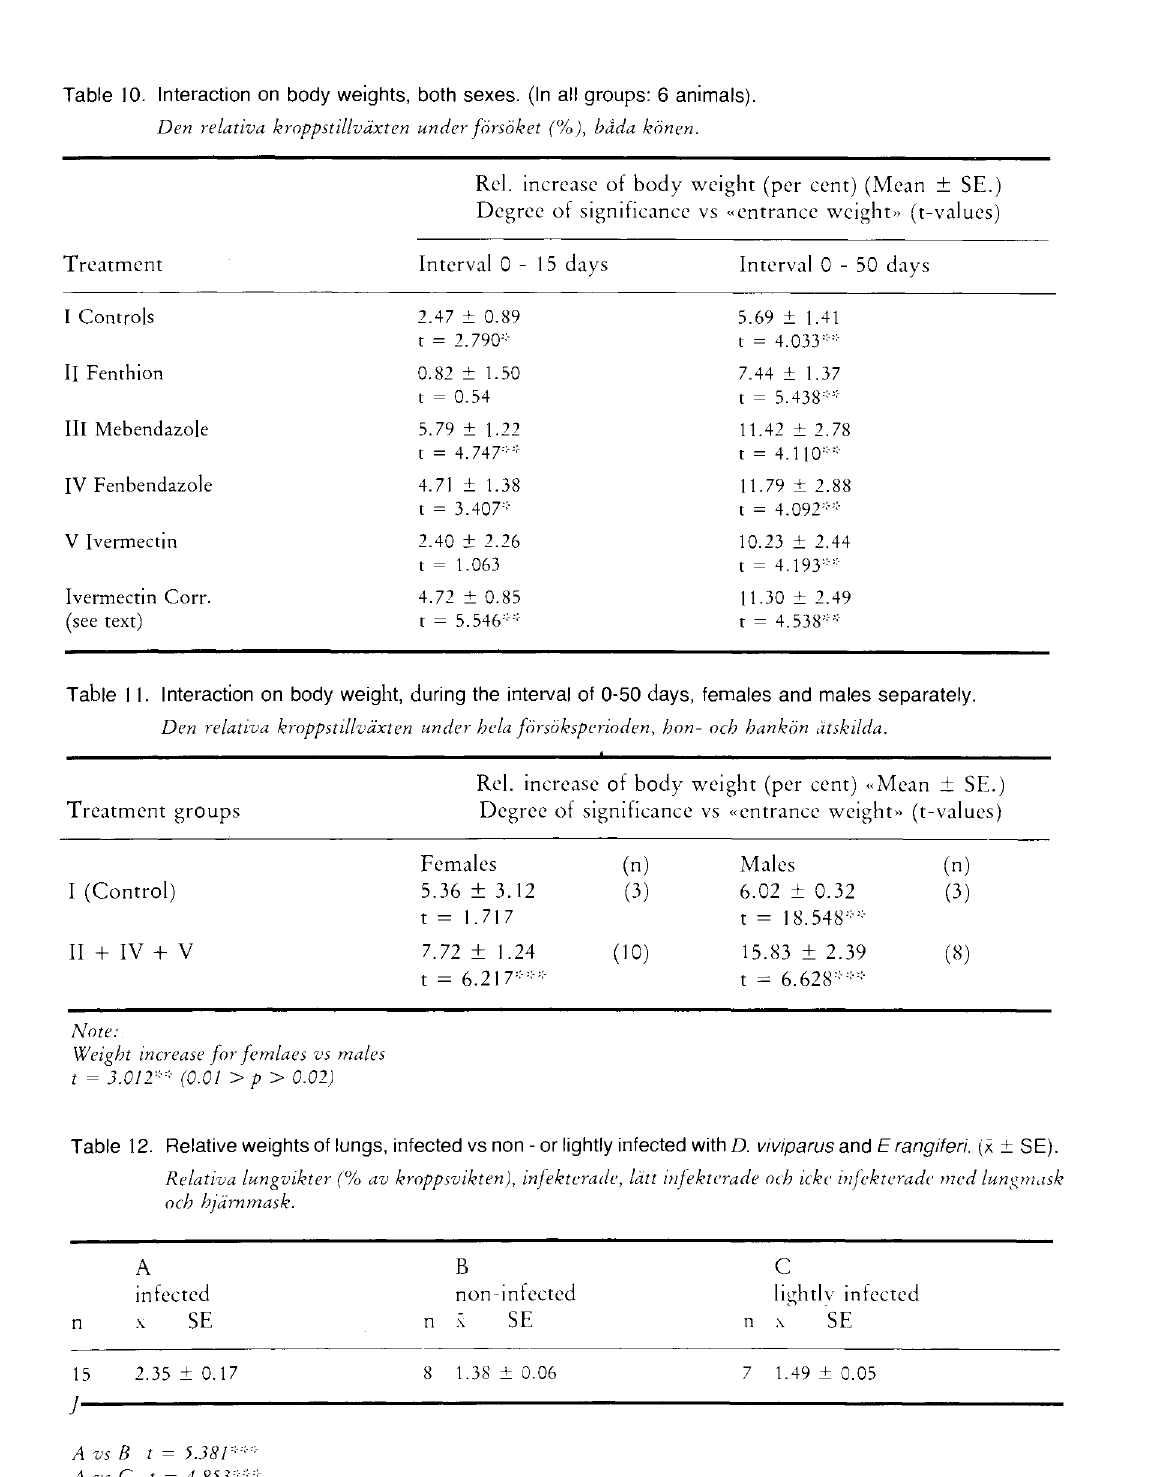
Table 10. Interaction on body weights, both sexes. (In all groups: 6 animals).